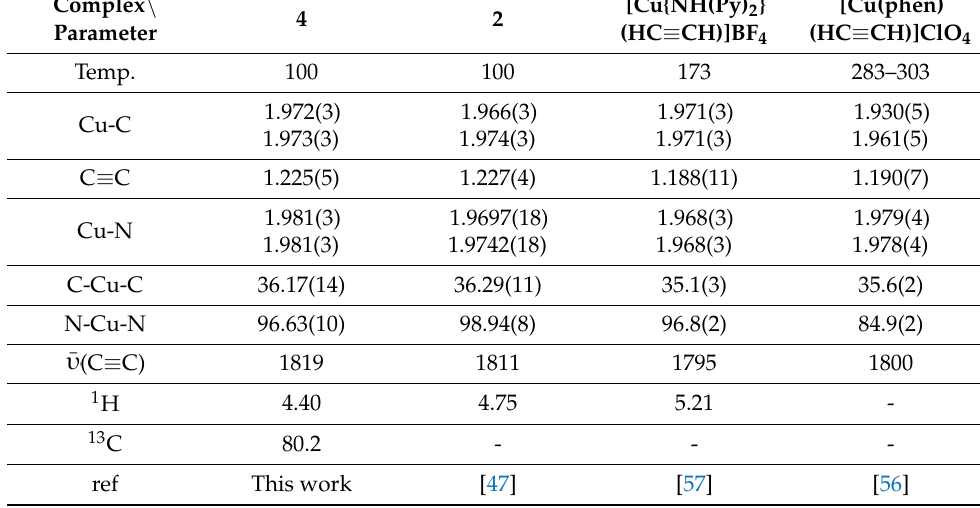
Table 1. Selected bond distances (Å) and angles (º) for [H 2 B(3,5-(CF 3 ) 2 Pz) 2 ]Cu(HC ≡ CH) (4), Cu 2 ( µ